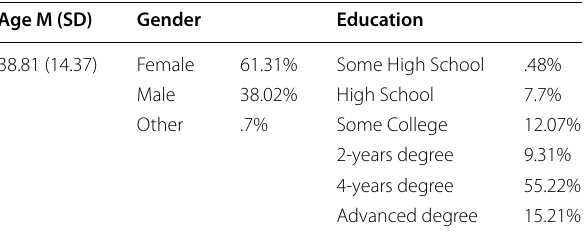
characteristics of